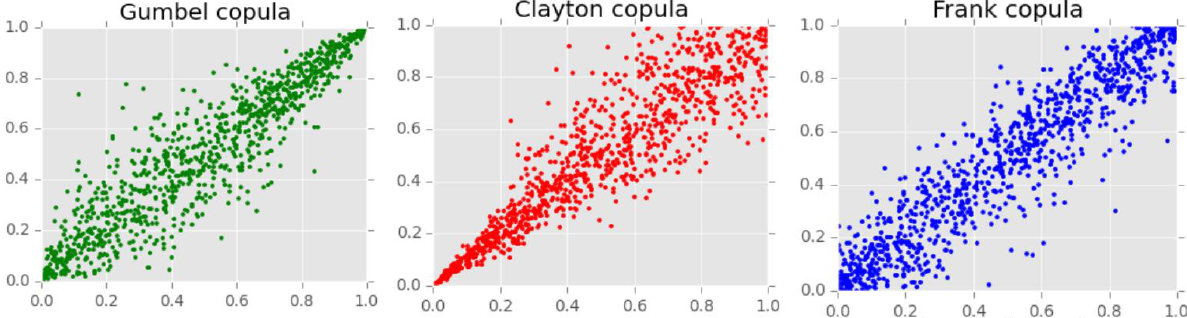
Figure 1. Concept visualization comparing the most-used Archimedean copulas.